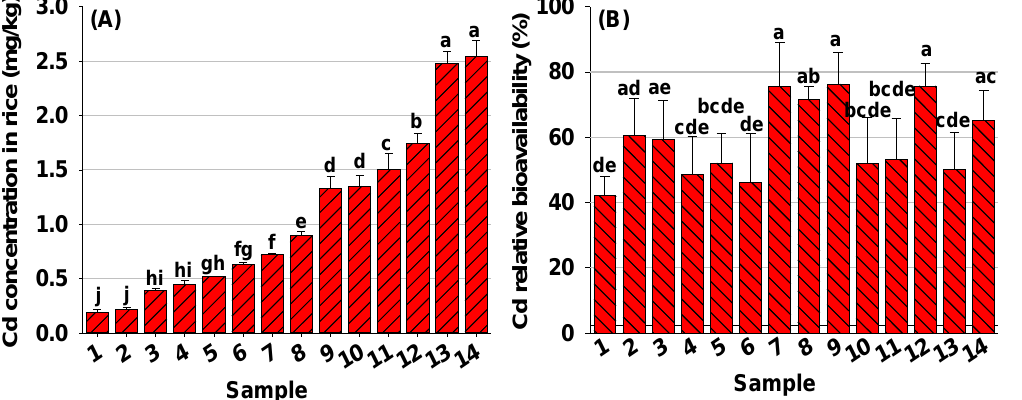
Figure 1. Cadmium concentration ( A ) and Cd relative bioavailability ( B ) in 14 rice samples. Different letters above bars indicate significant ( p < 0.05) difference among rice samples.